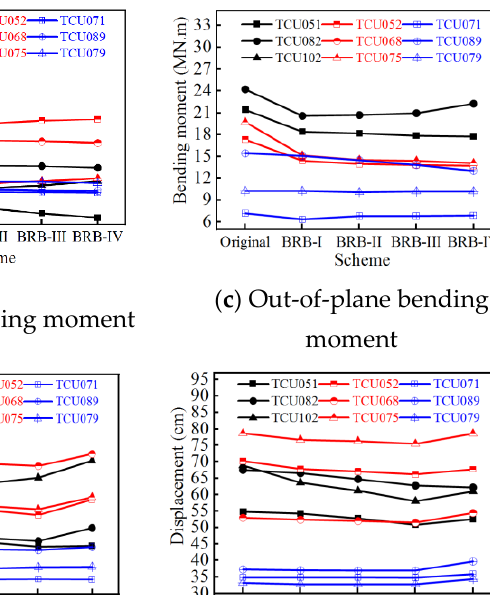
Figure 13. The seismic mitigation effect of BRBs on the internal force and displacement of arch rib.